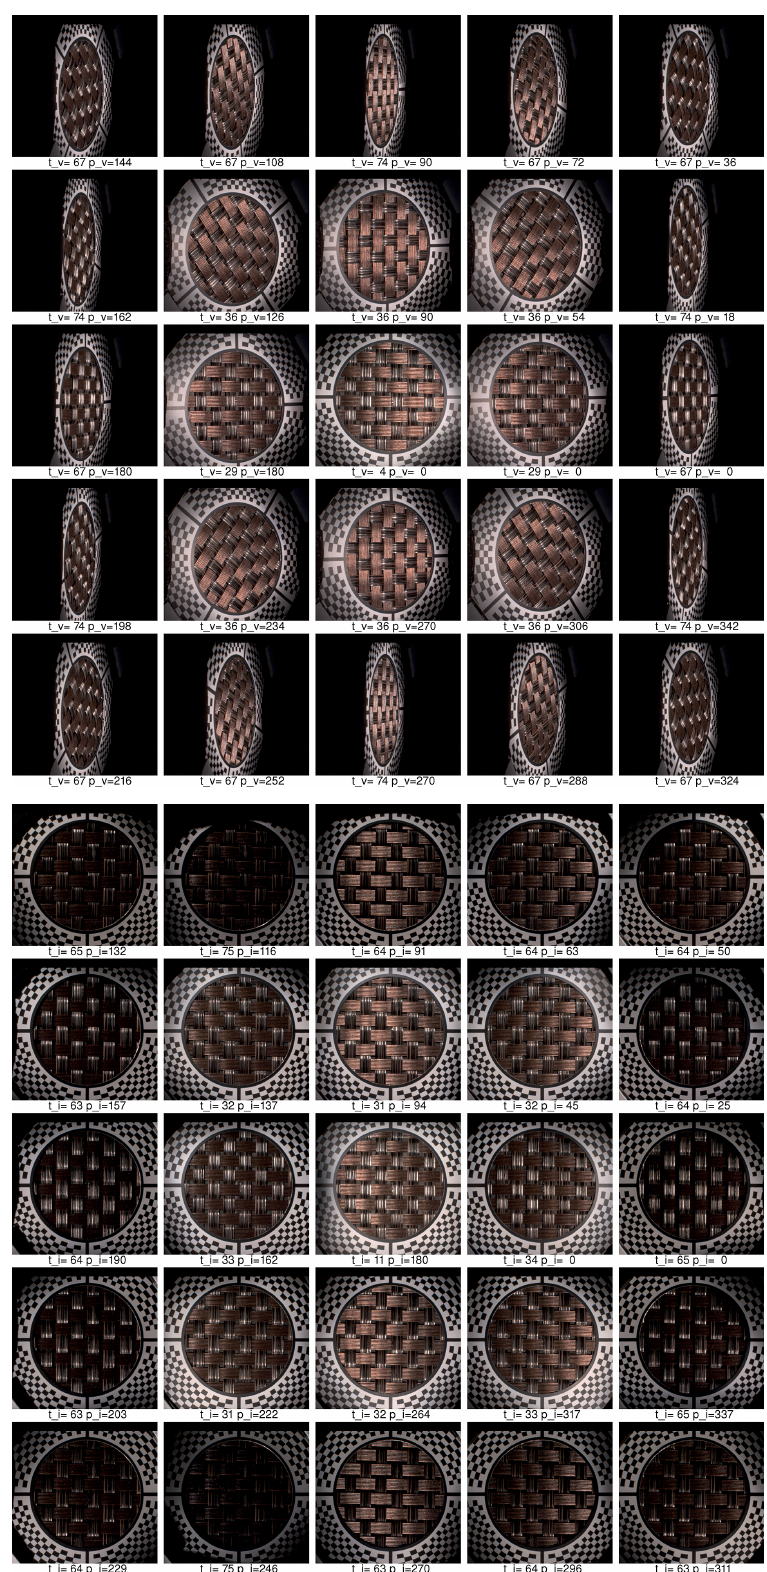
Figure 22. The example measurement data on example material sample 016-BasketWeave from The MAM 2014 sample set ([35]). ( top ) changing the viewing direction for illumination direction close to the normal for θ i = 12.5 ◦ ; ( bottom ) changing the illumination direction, the camera at direction θ v = 3.5 ◦ , φ v = 1 ◦